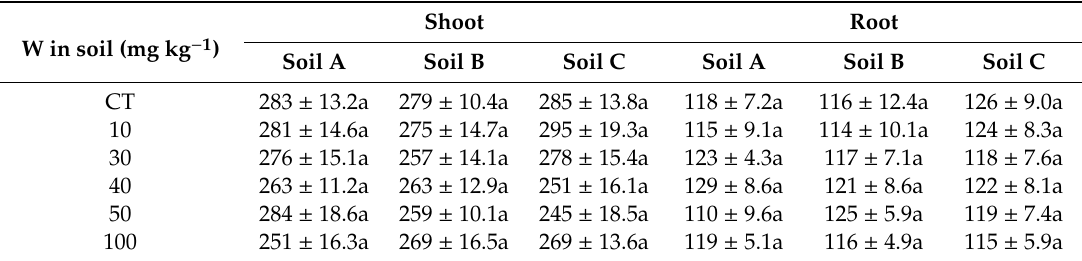
Table 2. Biomass production (mg dry weight) of shoot and root grown in the soils with increasing tungsten concentrations. CT is the original soil. Values are the mean ± standard deviation. Shoot Root W in soil (mg kg − 1 ) Soil A Soil B Soil C Soil A Soil B Soil C 283 ±